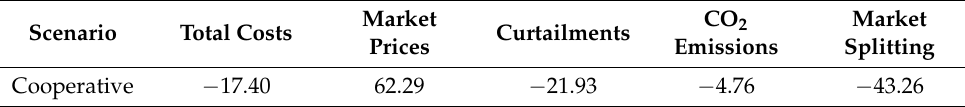
CO 2 Market Market Curtailments Prices Emissions Splitting